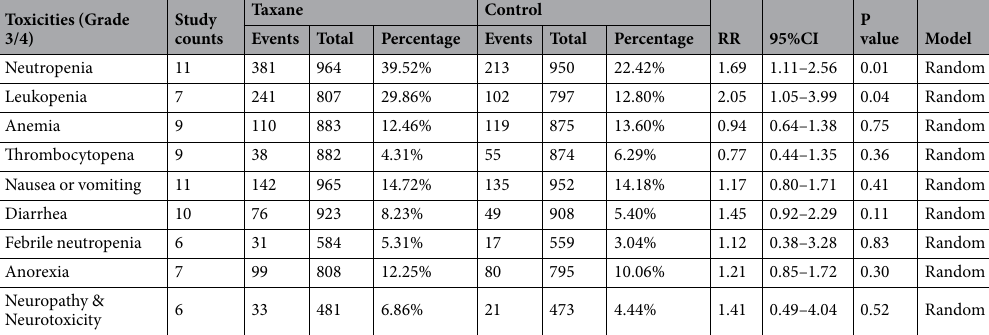
Table 2. Toxicities comparison between taxane-based and control chemotherapy.